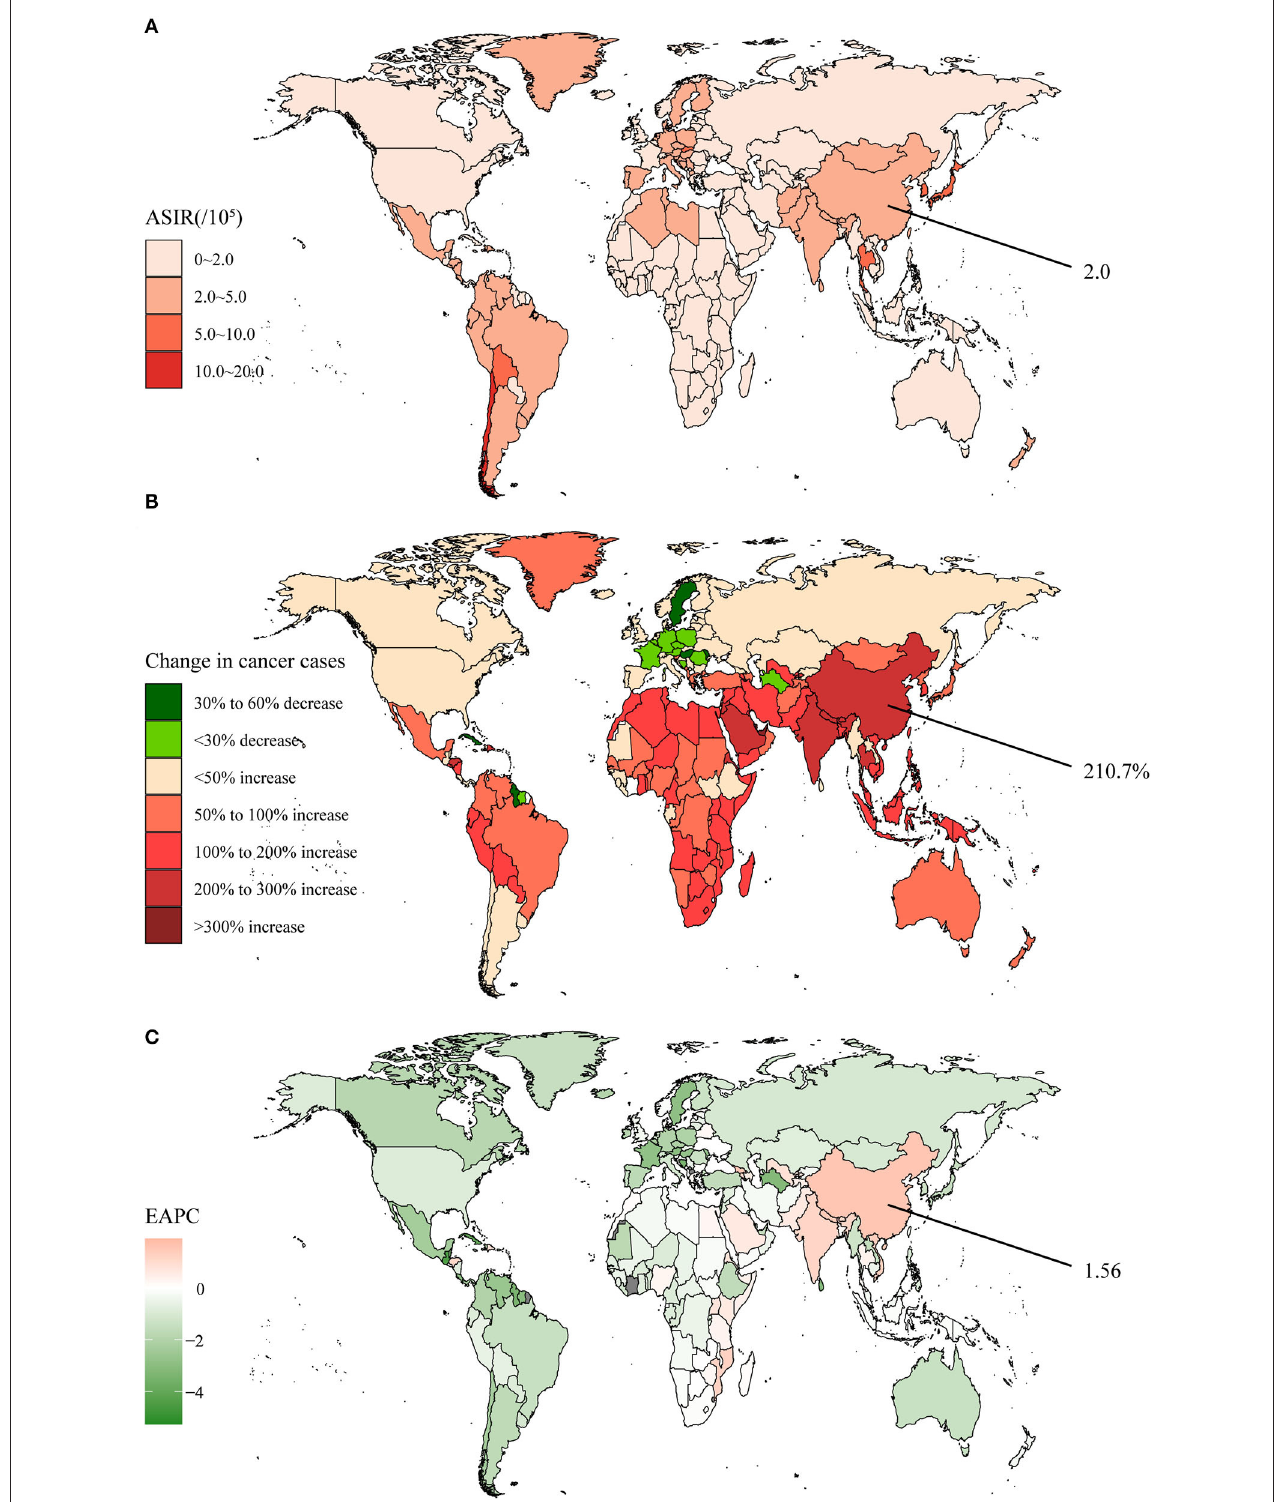
FIGURE 6 | The global disease burden of the gallbladder and biliary tract cancer in 204 countries and territories. (A) The ASIR in 2019; (B) The relative change in incident cases between 1990 and 2019; (C) The EAPC of ASIR from 1990 to 2019. Outcomes of China were specifically annotated. ASIR, age-standardized incidence rate; EAPC, estimated annual percentage